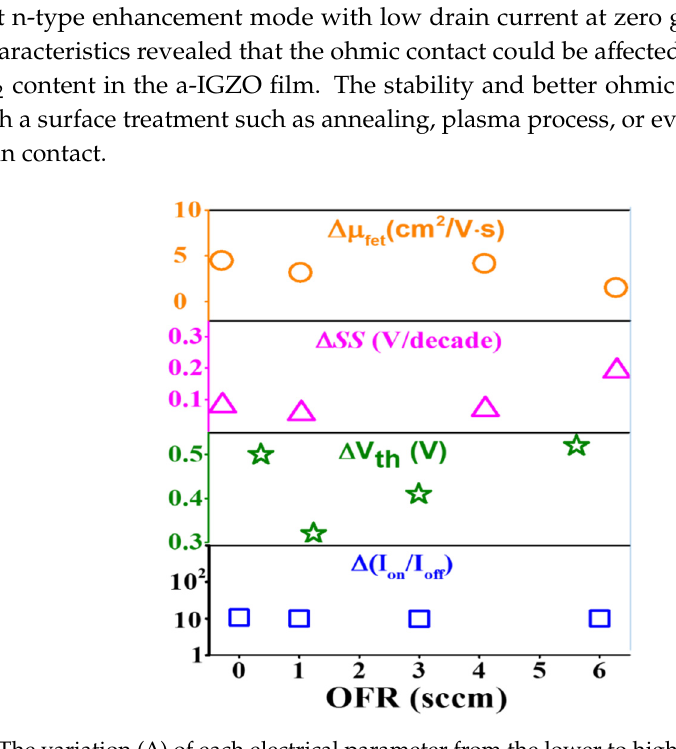
Figure 9. The variation ( ∆ ) of each electrical parameter from the lower to higher sizes channel width with the various O 2 flow rates.